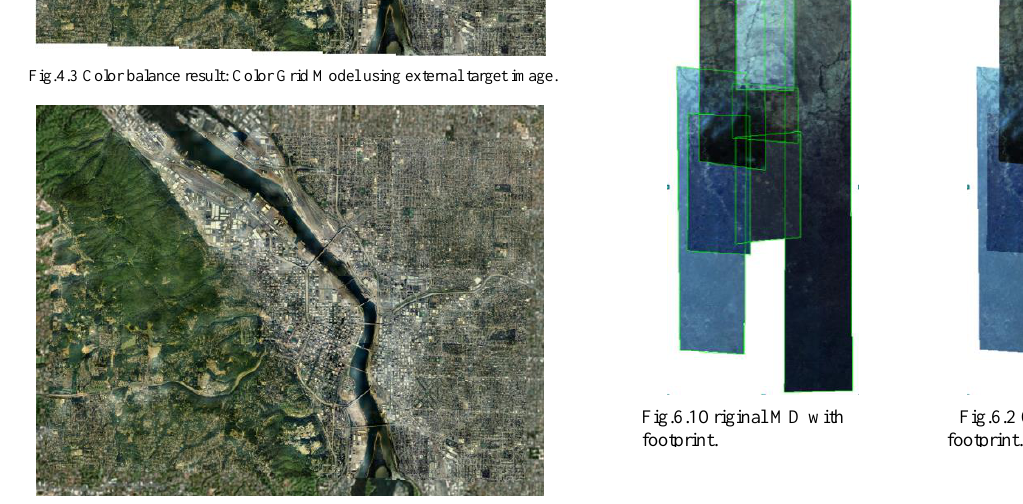
Fig.4.4 Color balanced mosaic dataset superimposed on the external image.